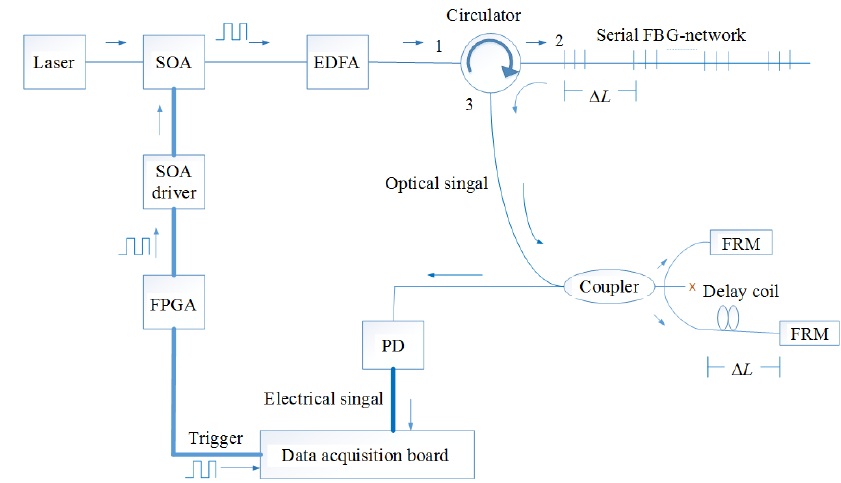
Fig. 1 Principle diagram of the distributed weak fiber Bragg grating vibration sensor system.